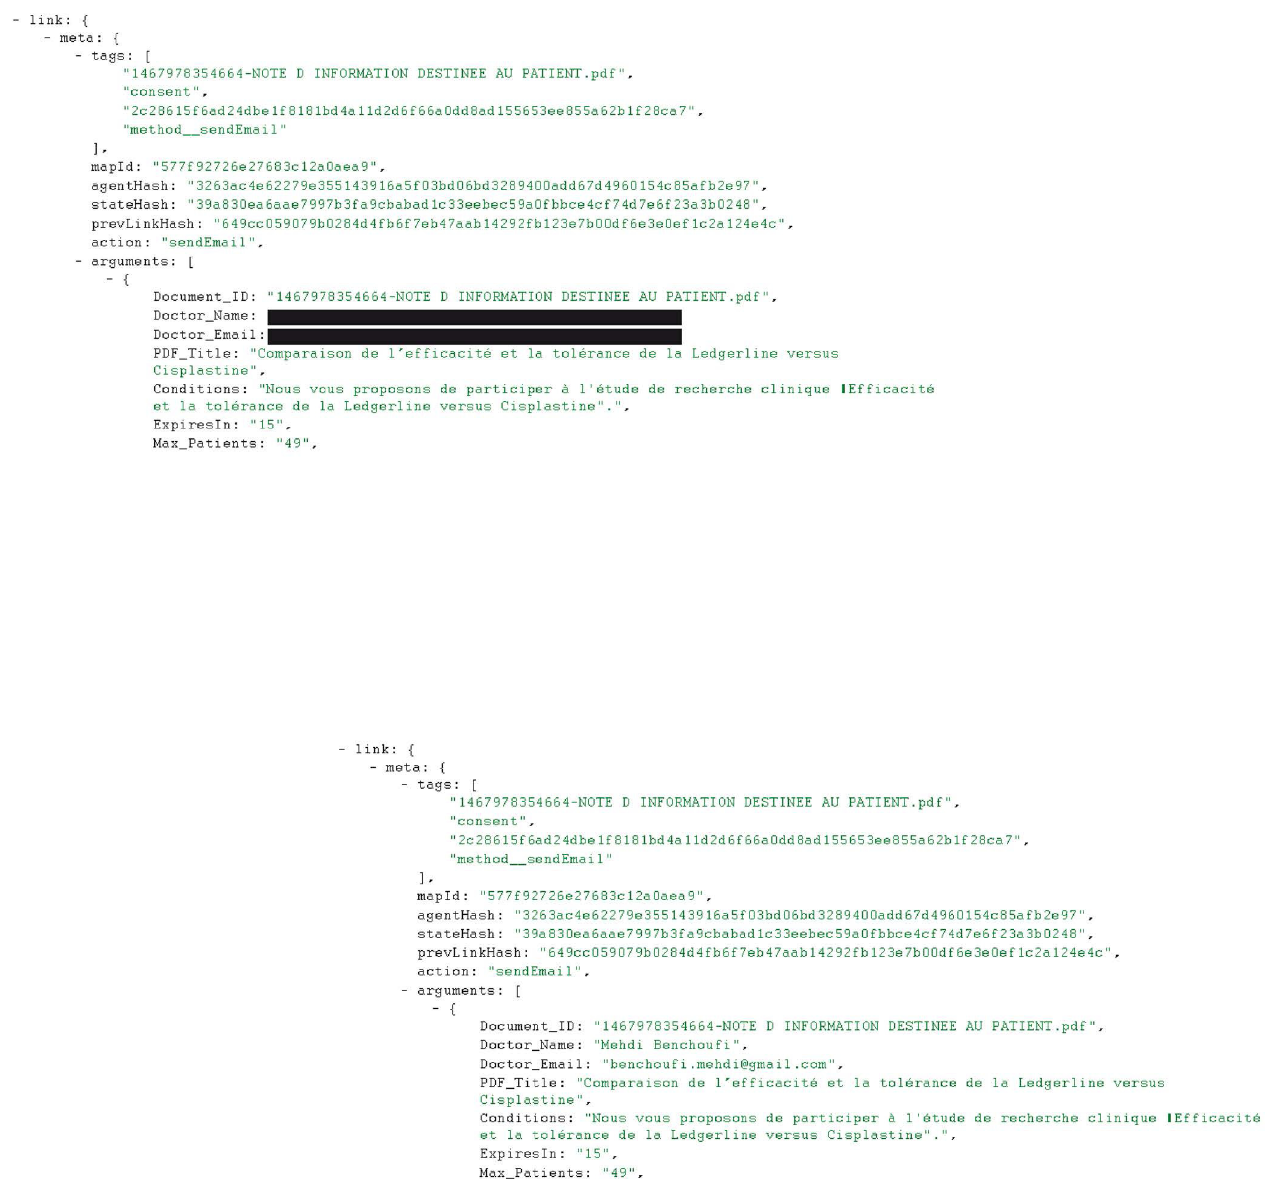
Figure 5. Consent collection master document: investigator